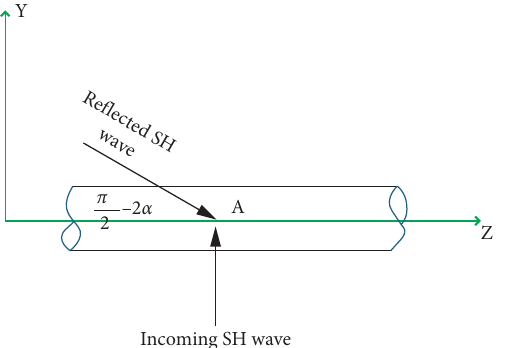
Figure 3: Tunnel lining strain of thin-walled elliptical cylindrical shell. Y